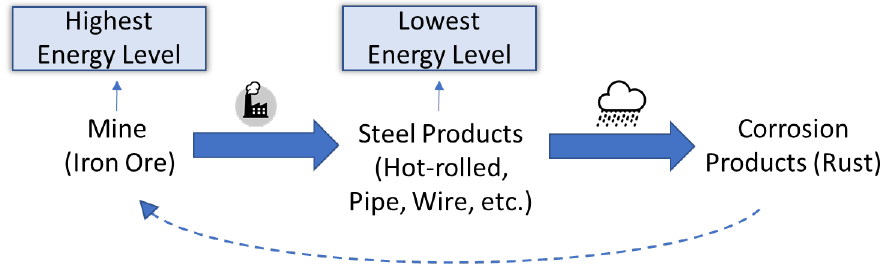
Figure 1. Refining corrosion cycle of steel components.